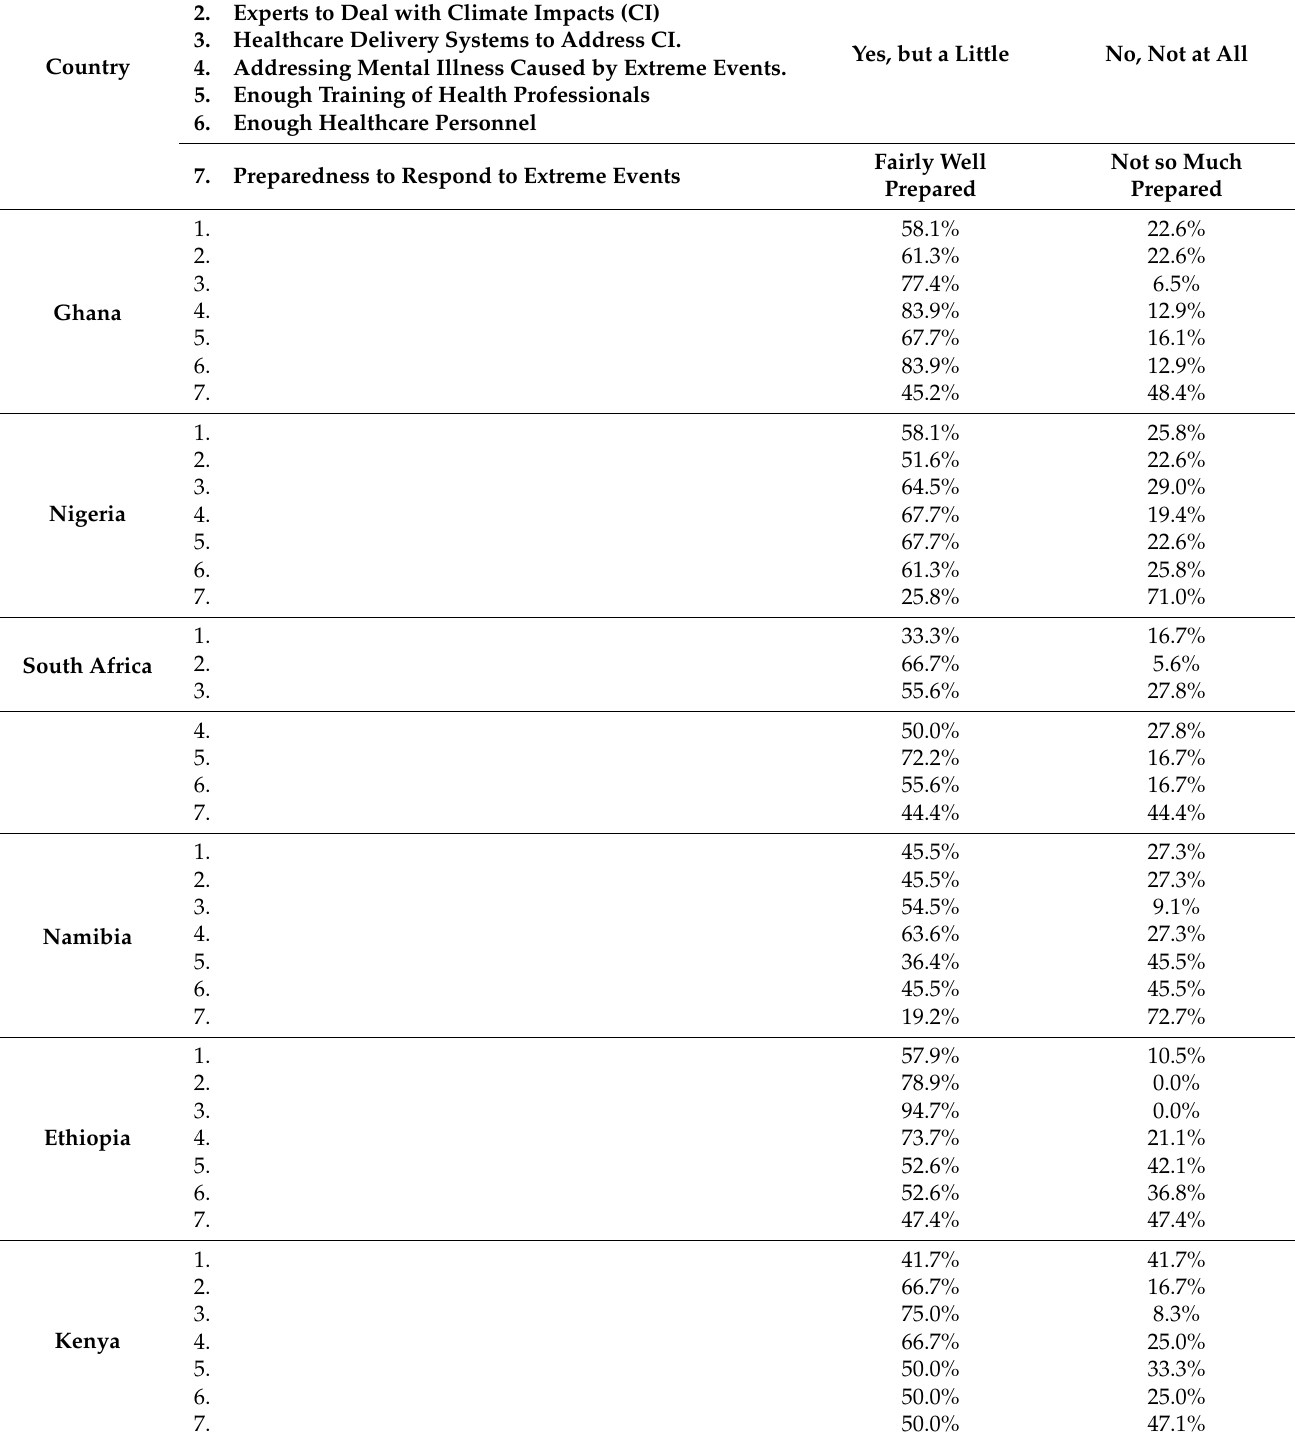
Table 6. Respondents’ perceptions of the health system’s preparedness in dealing with the health impacts of climate (CI) change in sampled countries. Numbers are assigned to their respective survey questions on top of the table. Even though percentages summed up to 100, this table’s options are of greater importance to this study (see Appendix A). This applies to all other subsequent tables with similar instances. All percentages are recorded within each country’s number of respondents to identify specific features